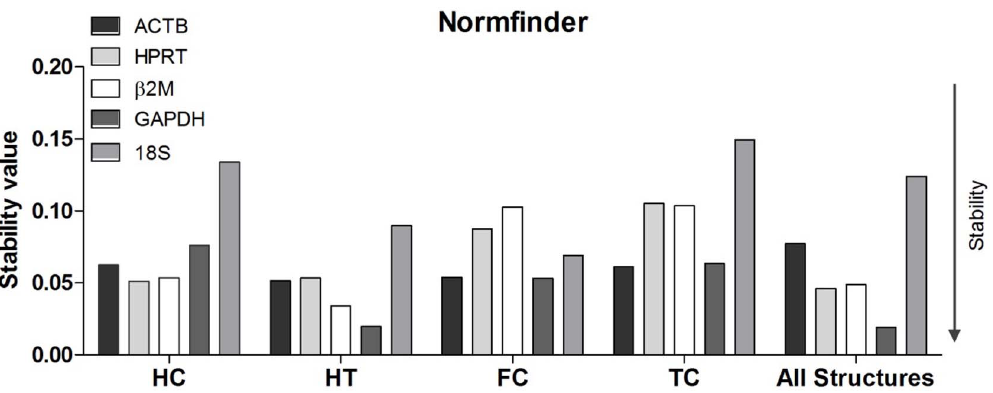
Figure 3. Normfinder stability analysis. Evaluation of gene expression stability by Normfinder for individual brain regions. All HKG candidates presented values that were lower than the cut-off value (0.15). HC, hippocampus; HT, hypothalamus; FC, frontal cortex; TC, temporal